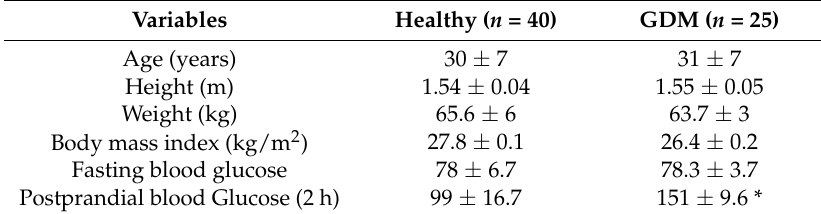
Table 1. Demographic characteristics of study